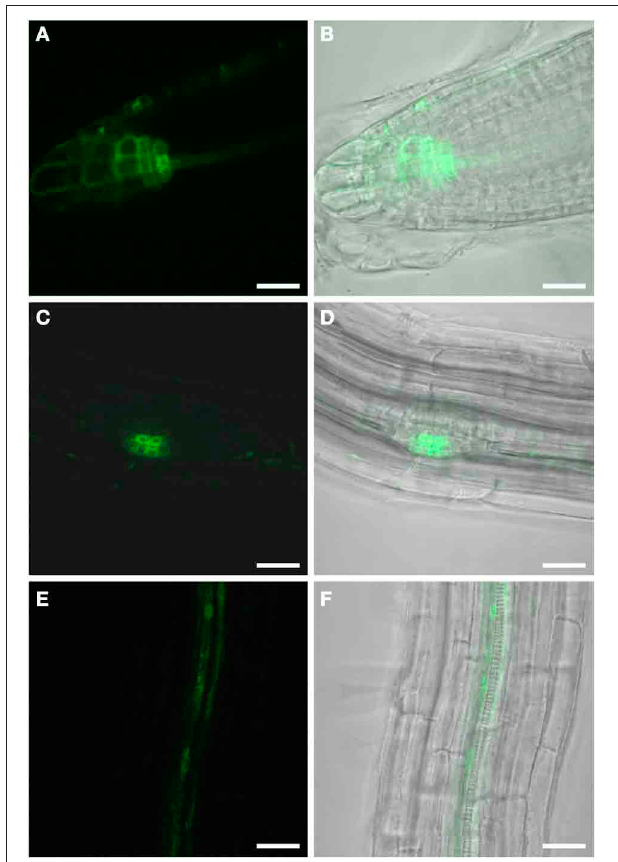
FIGURE 1 | GFP fluorescence in uninfected roots of 2-week old P DR5 :ER - GFP Arabidopsis plants. Fluorescence is observed in auxin responsive tissues. (A,B) Root tip (A) GFP channel (B) Overlay of GFP fluorescence and bright field image. (C,D) Lateral root primordium (C) GFP channel (D) Overlay of GFP fluorescence and bright field image. Within the vasculature approximately 2cm above the root tip (E,F) fluorescence is observed in two cell files. (E) GFP fluorescence (F) Overlay of GFP fluorescence and bright field image. Scale bars represent 20 µ